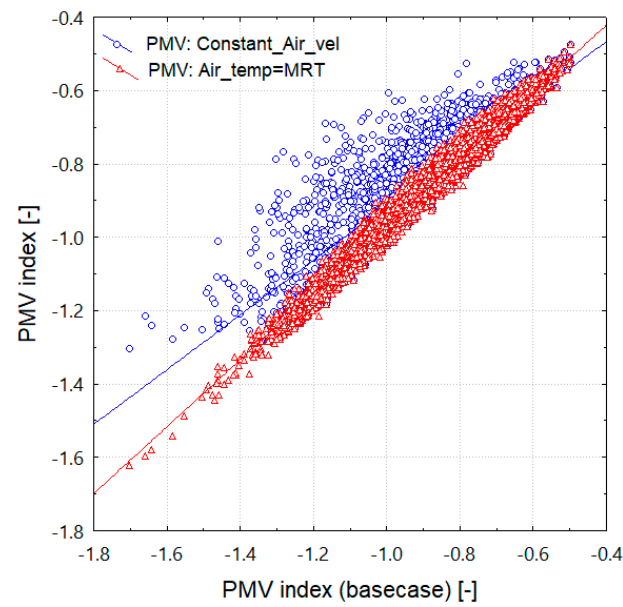
Figure 9. Predicted mean vote (PMV) error between the basecase and two scenarios.